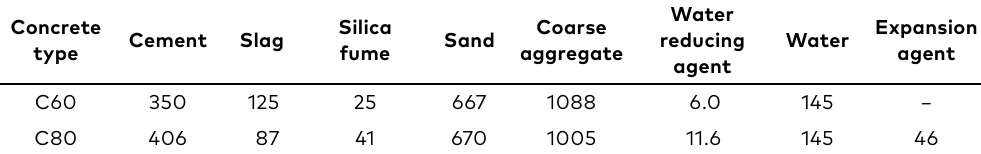
Table 1. Concrete mix specification (kg/m 3